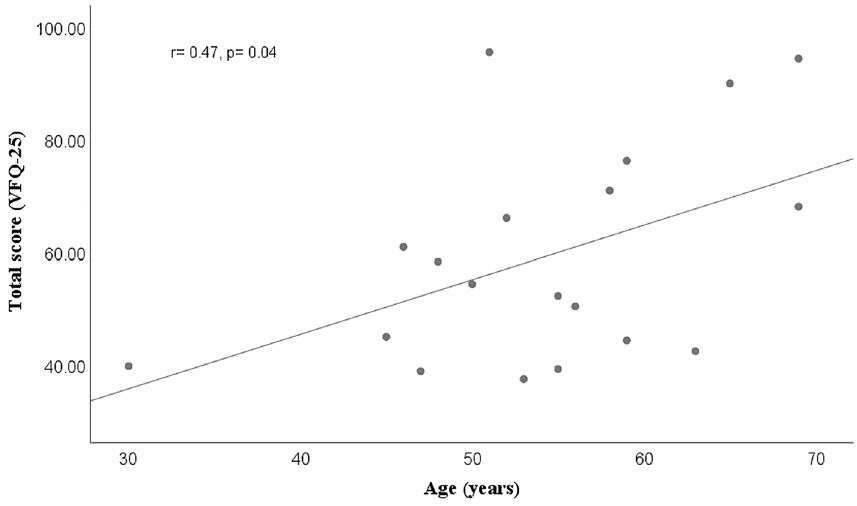
Figure 2. Moderate positive linear correlation between age and quality-of-life total score in diabetic retinopathy subjects, 3 months after undergoing vitrectomy.